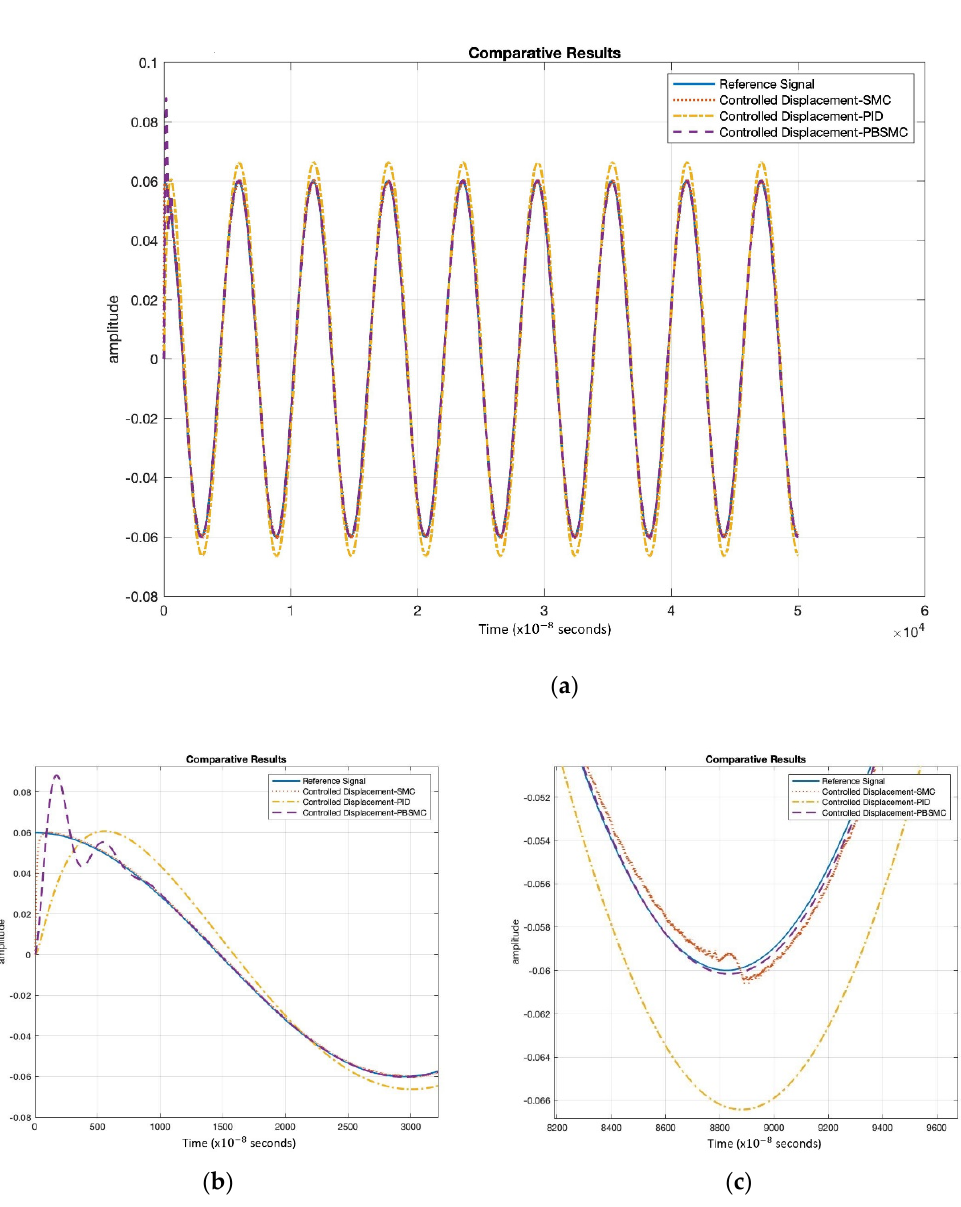
Table 5. Sliding Mode Controller Parameters.